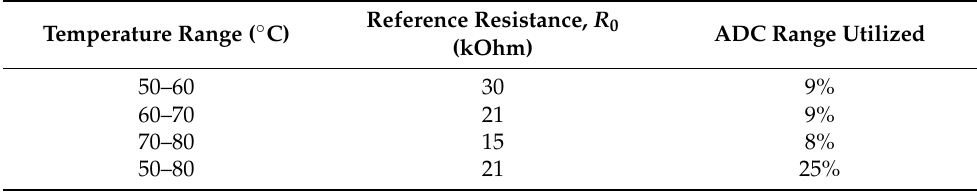
Table 2. Optimized reference resistances for several operating temperature ranges.